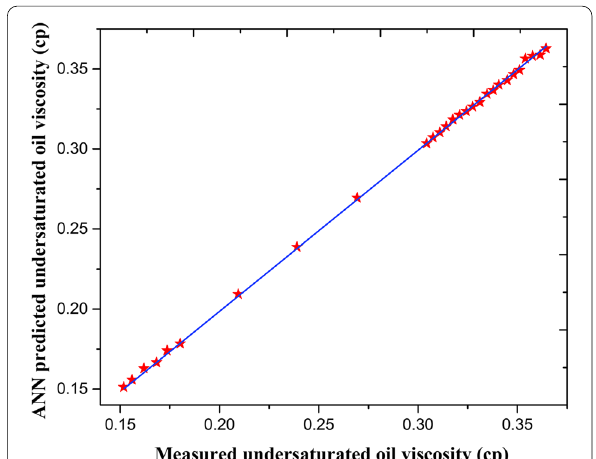
Fig. 6 Cross plot of ANN predicted values versus measured values